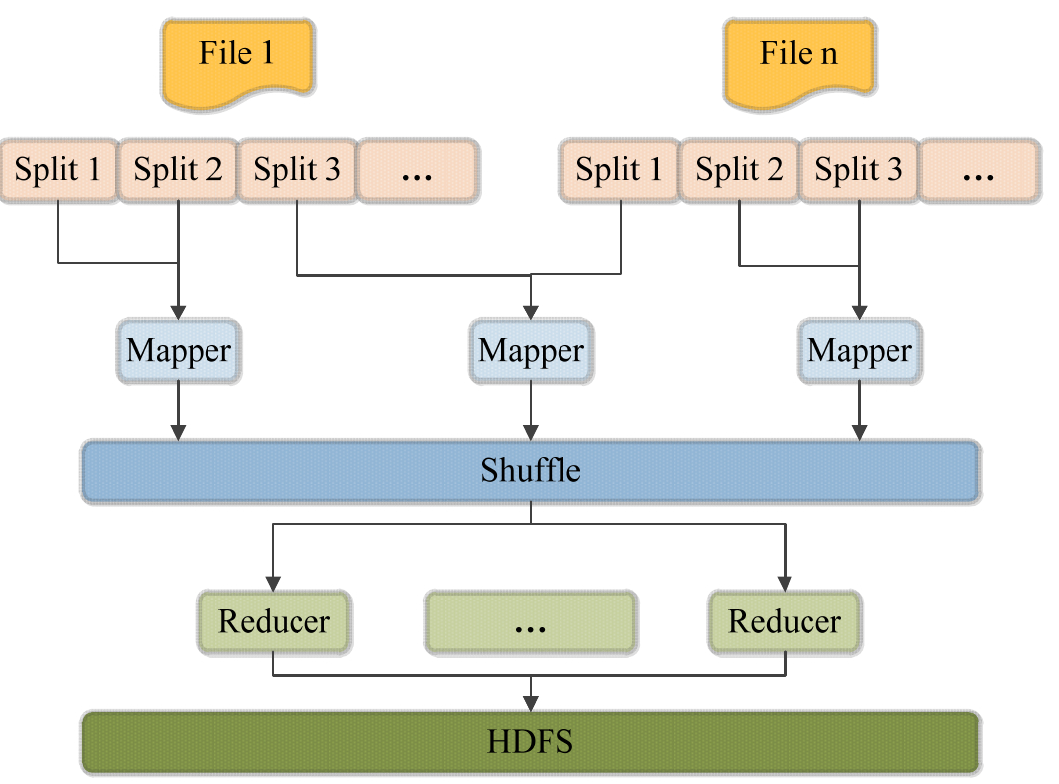
Figure 10. MapReduce programming model.